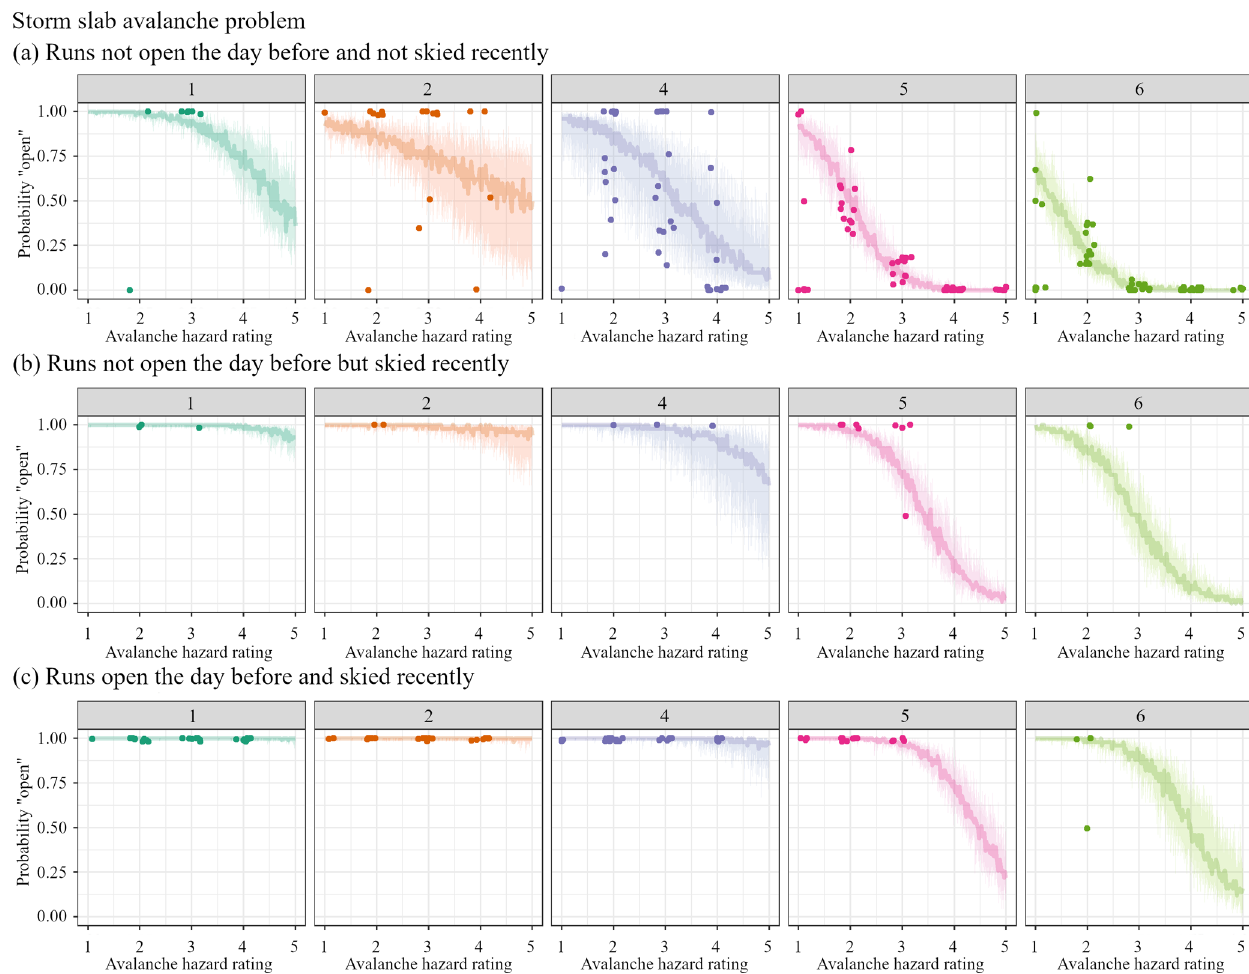
Figure 5. Probabilities of ski runs being open for Storm slab avalanche problems shown for increasing hazard levels with (a) a scenario where ski runs were neither open previously nor skied recently, (b) a scenario where runs were not open the day before but recently skied, and (c) a scenario where runs were open the day before and recently skied. The visualizations include probability intervals of 50% and 95% for each ski run class as a whole based on 50 draws from the posterior distribution. Average daily percentages of open runs per ski run class are plotted as points where observations for this scenario exist in the